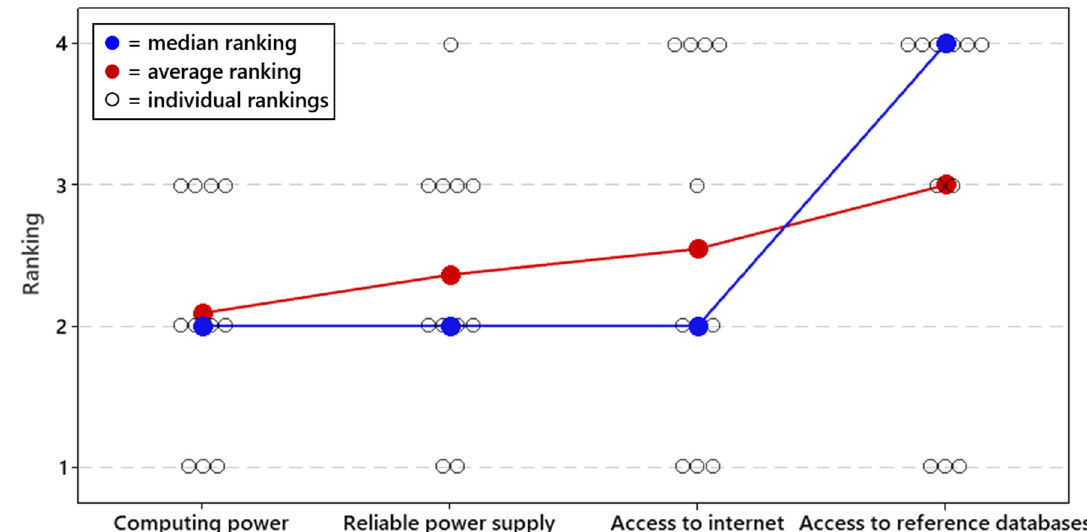
Figure 4. Priorities for field-forward sequencing applications. Respondents ranked all challenges on a priority scale of 1 to 4, with 1 being the most important and 4 being the least important issue to overcome. The average and median rankings for each challenge are provided in Figure 4, along with all individual responses.